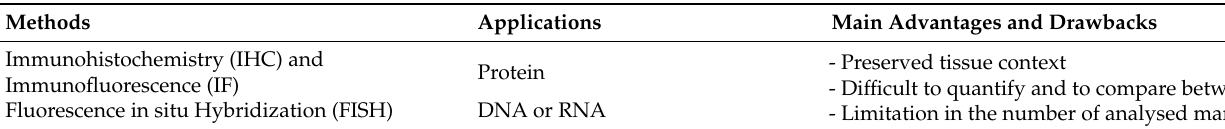
Table 1. Methodologies for studying the tumour